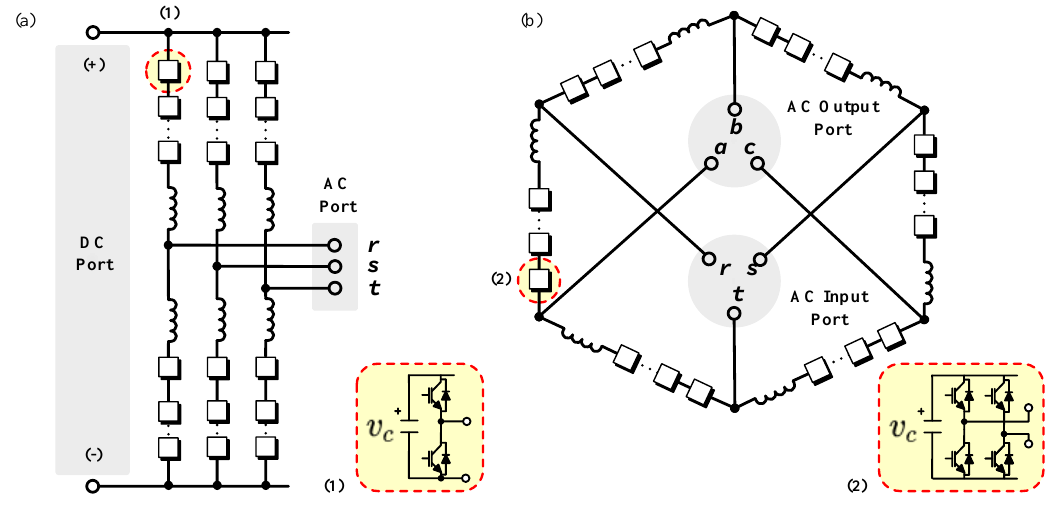
Figure 6. MMCC topologies. ( a ) M 2 C . ( b )